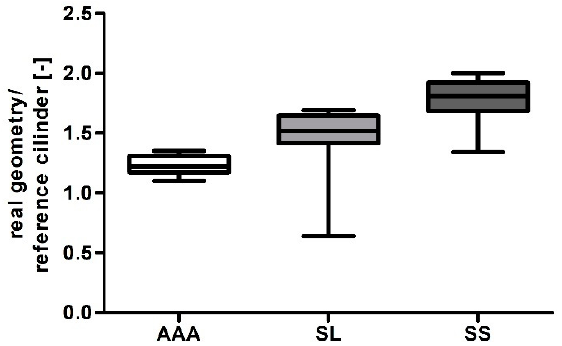
Figure 3. Bar chart representation of relation between a real geometry and a reference cylinder for abdominal aortic aneurysm (AAA), long stent-graft (SL), and short stent-graft (SS).